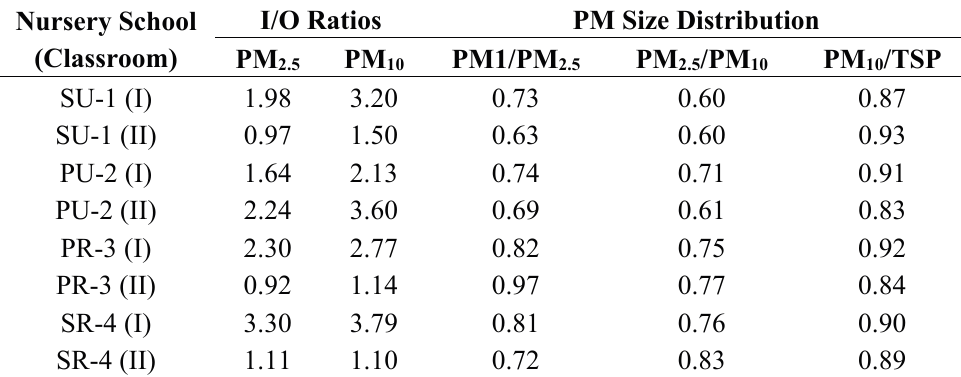
Table 4. Indoor/outdoor (I/O) ratios and PM size distribution in each studied classroom. Nursery